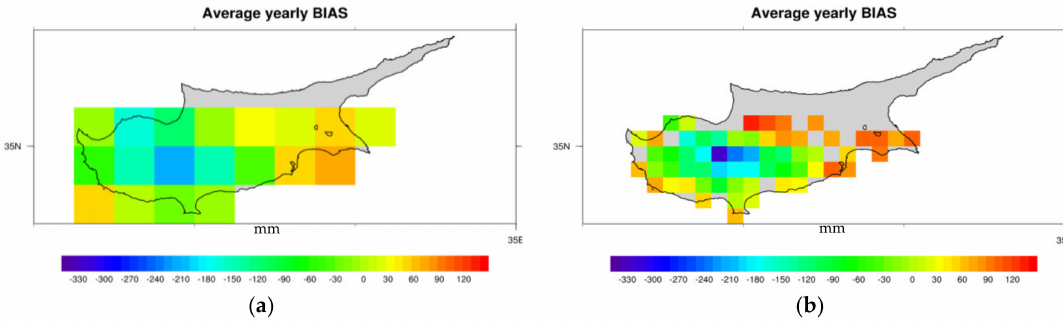
Figure 9. Annual bias for both precipitation products for the study period: ( a ) TRMM and ( b ) GPM.